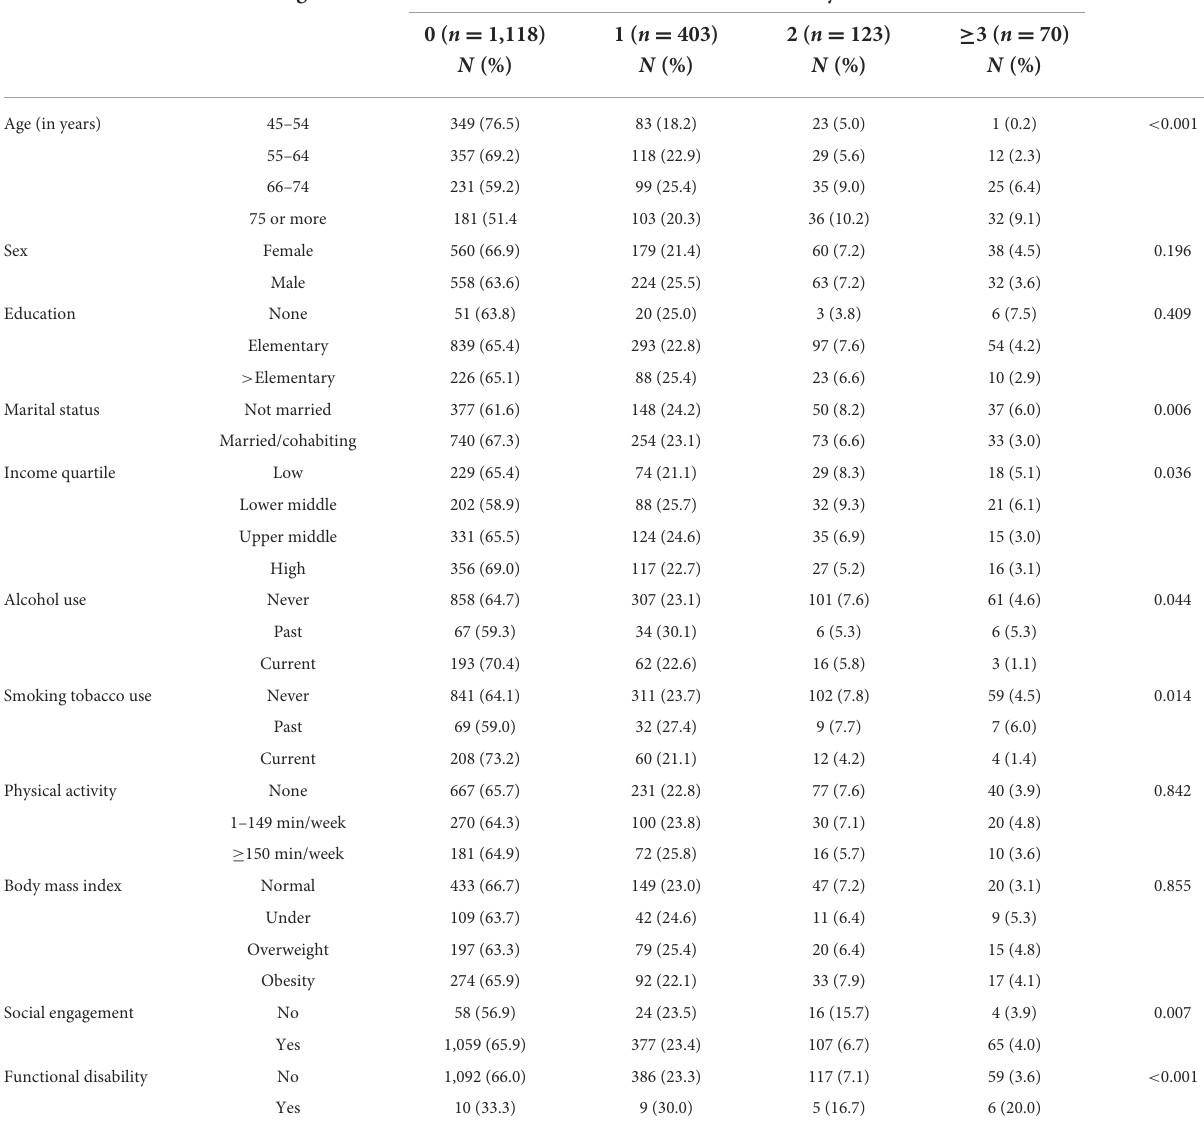
TABLE 2 Sample characteristics of participants with incident morbidity, Thailand,